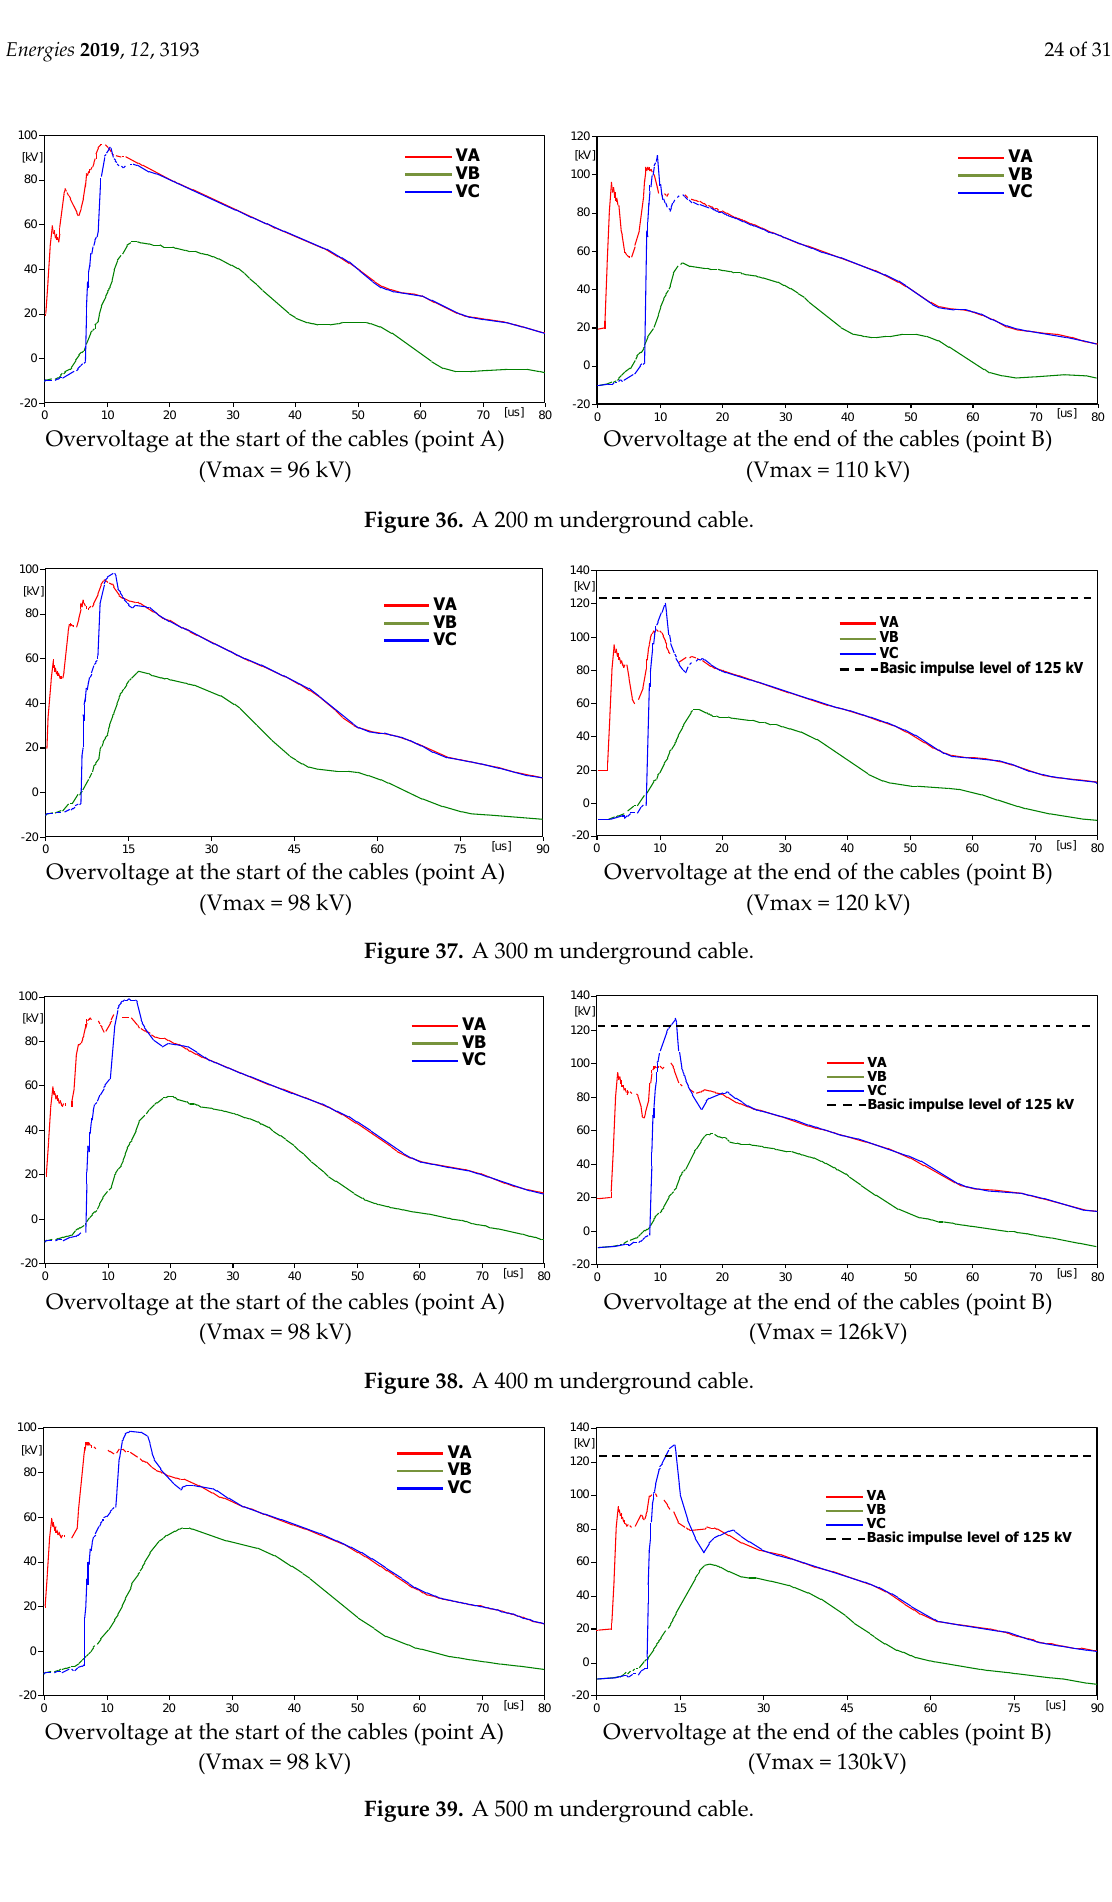
(Vmax = 132 kV) Figure 40. A 600 m underground cable. Scenario 3: Protection with A Lightning Arrester, Both at the Conjunction (Point A) and the End of Underground Cables (Point B) Figures 41 – 47 can be summarized, as shown in Table 8. The results show that the system is protected by lightning arrester at both the connected point (point A) and the end of the underground lines (point B), in the case of a lightning strikes to the phase conductor causing overvoltage throughout the cable of less than 125 kV.